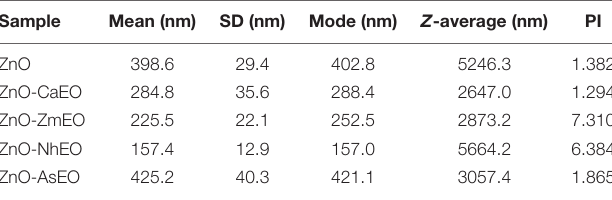
TABLE 3 | DLS size distribution data of ZnO and ZnO-Eos.